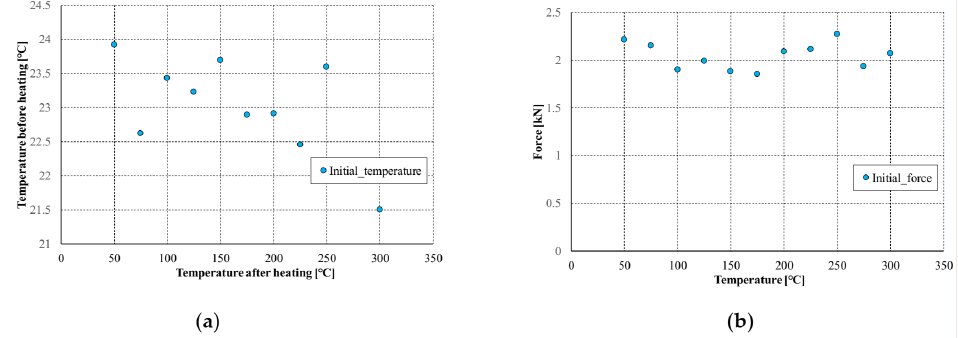
Figure 9. Average values of initial compressive forces ( a ) and ambient temperatures ( b ) before